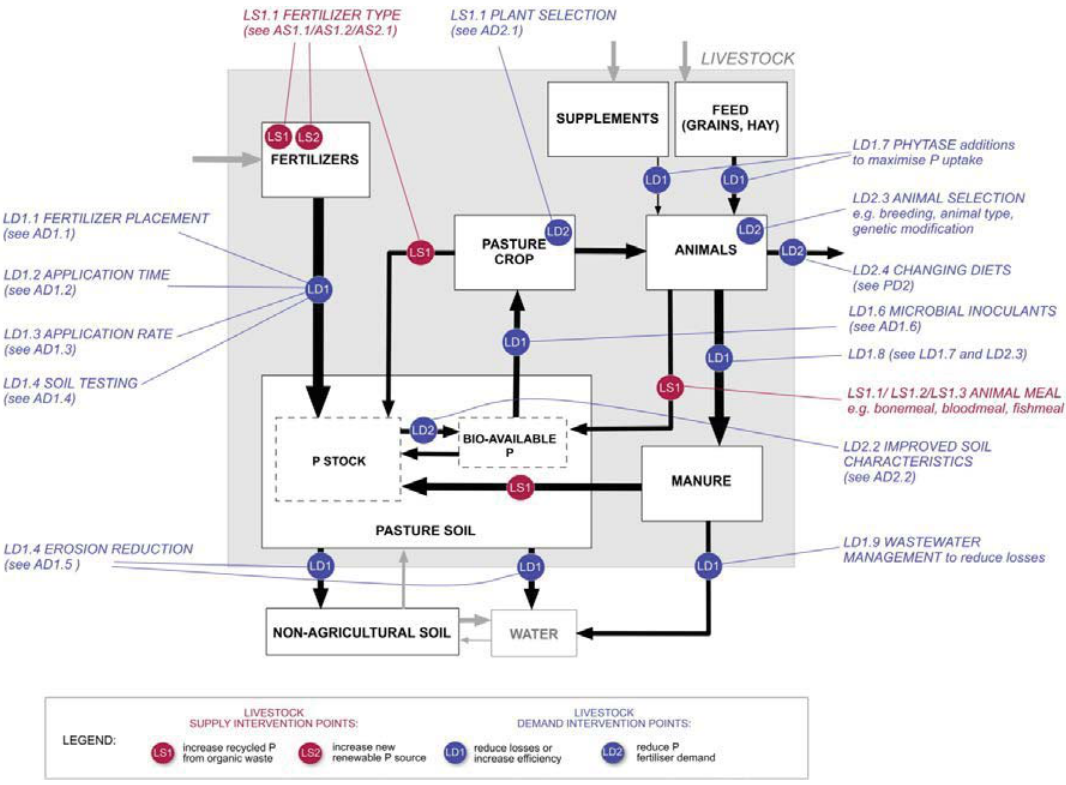
Figure 6. Sustainable phosphorus measures in the livestock sector—interventions in animal selection, fertilizer selection and application, soil management and plant